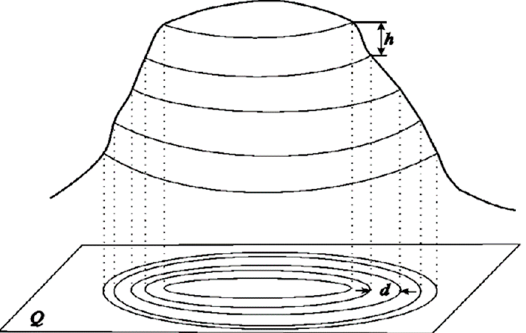
Figure 6. A set of surface-level lines.